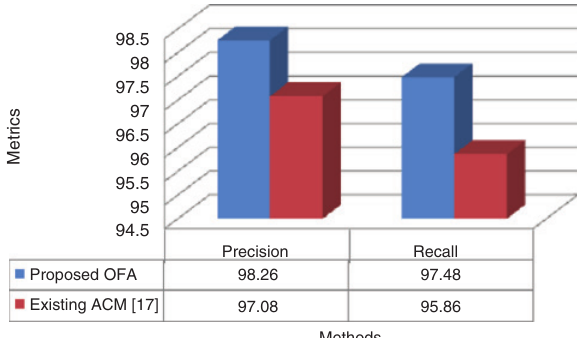
Figure 11: Comparative Analysis of Precision and Recall